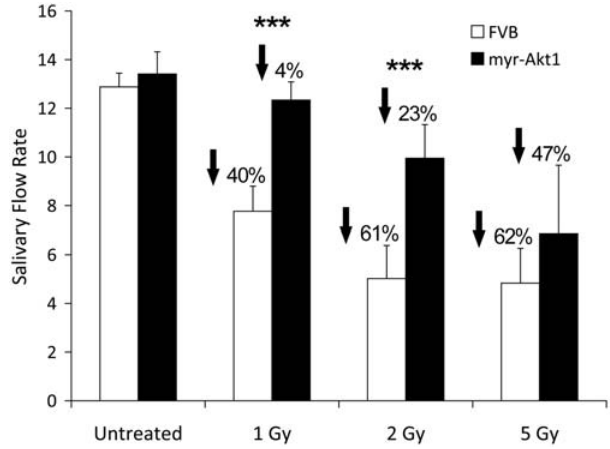
Figure 2. Preservation of salivary flow rates 3 days after single c -radiation exposure in myr-Akt1 mice. Four-week old female FVB and myr-Akt1 mice were exposed to 1, 2, or 5 Gy c -radiation. Three days after irradiation total saliva was collected (over a five minute period) following carbachol injection. Statistical analysis was performed using Student’s t-test in Microsoft Excel. Results shown are from ten mice per group in the 1 and 2 Gy doses and four mice per group in the 5 Gy dose. Graphs represent averages and SEM from all mice. Significant differences (p # 0.05) were determined using a two sample t-test comparing FVB to myr-Akt1 and significant differences are marked with an asterisk (*).